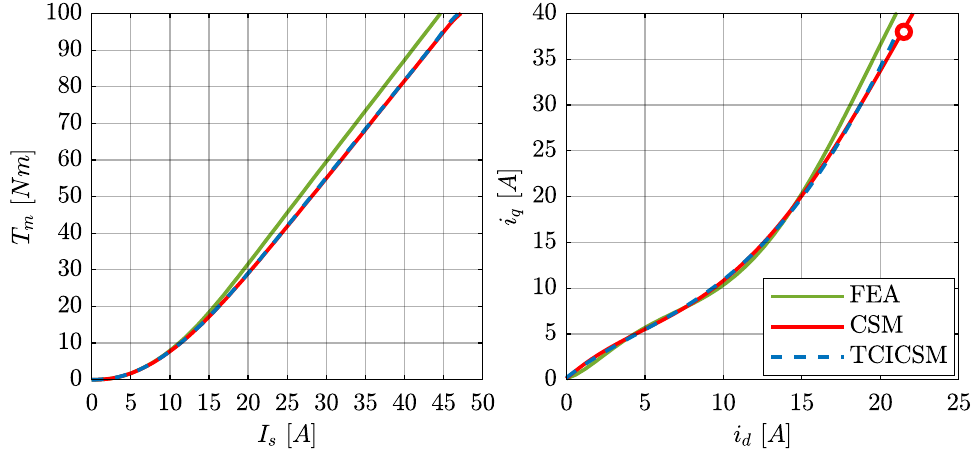
Figure 18. Comparison of MTPA characteristics: maximum torque versus phase current ( left ), control trajectories ( right